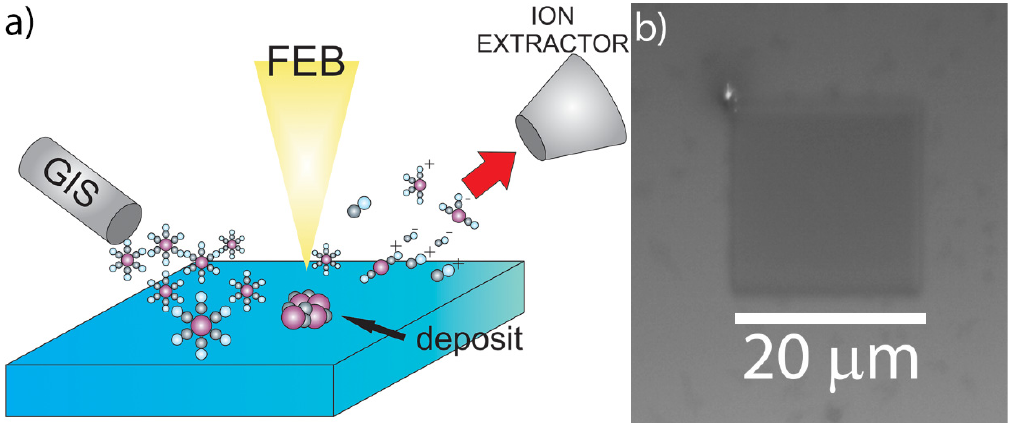
Figure 5. ( a ) Schematic of FEBiMS monitoring during FEBID. The precursor W(CO) 6 is delivered through a GIS. The electron beam fragments the surface-adsorbed molecules and the non-volatile fragments form the FEBID deposit. Volatile ionized fragments are extracted to the mass spectrometer; neutral fragments cannot be detected and are pumped away. The 55° tilt of the sample and neutral fragments were omitted for clarity. ( b ) Top-view SEM image of the deposited square from W(CO) 6 .